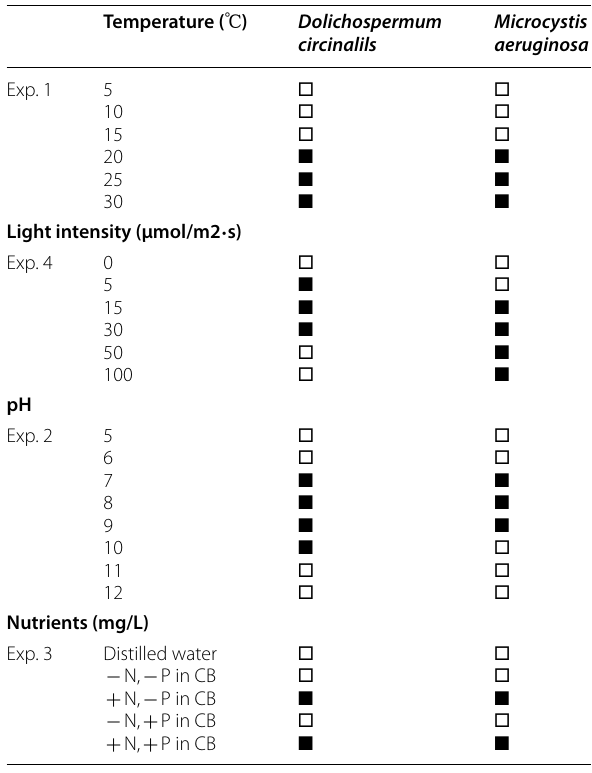
light intensity, pH, and nutrient conditions on the buoyancy of Dolichospermum circinalils and Microcystis